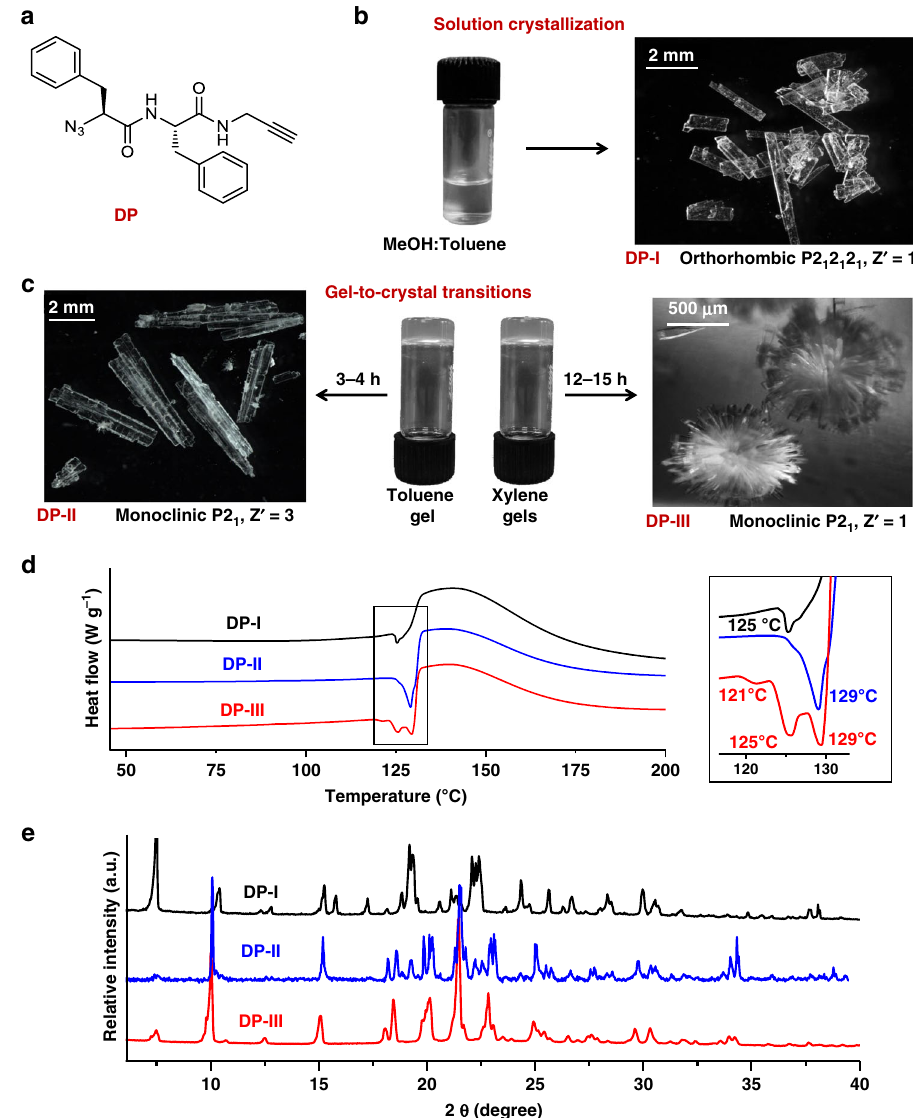
Fig. 1 Polymorphs of the dipeptide (DP). a Chemical structure of the dipeptide (DP). b Crystals of the dipeptide (DP-I) obtained from solution (MeOH:Toluene). Scale bar = 2 mm. c Crystals of the dipeptide obtained from gels; toluene gel (DP-II, scale bar = 2 mm) and xylene gel (DP-III, scale bar = 500 µ m). d DSC thermograms of the trimorphs of DP. e PXRD patterns of the trimorphs of DP. Source data are provided as a Source Data fi le for Fig. 1d,